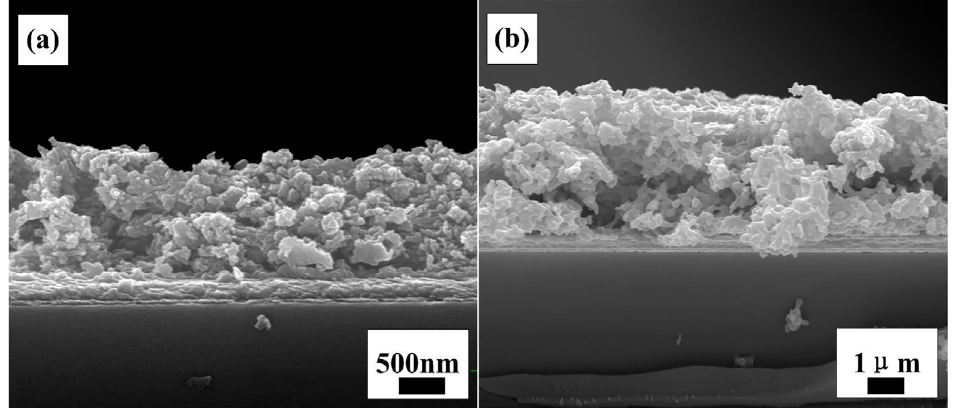
Figure 3. SEM images of the cross ‐ sections of TiO 2 thin films prepared by pulling: ( a ) one time; ( b ) seven times. ( b ) seven